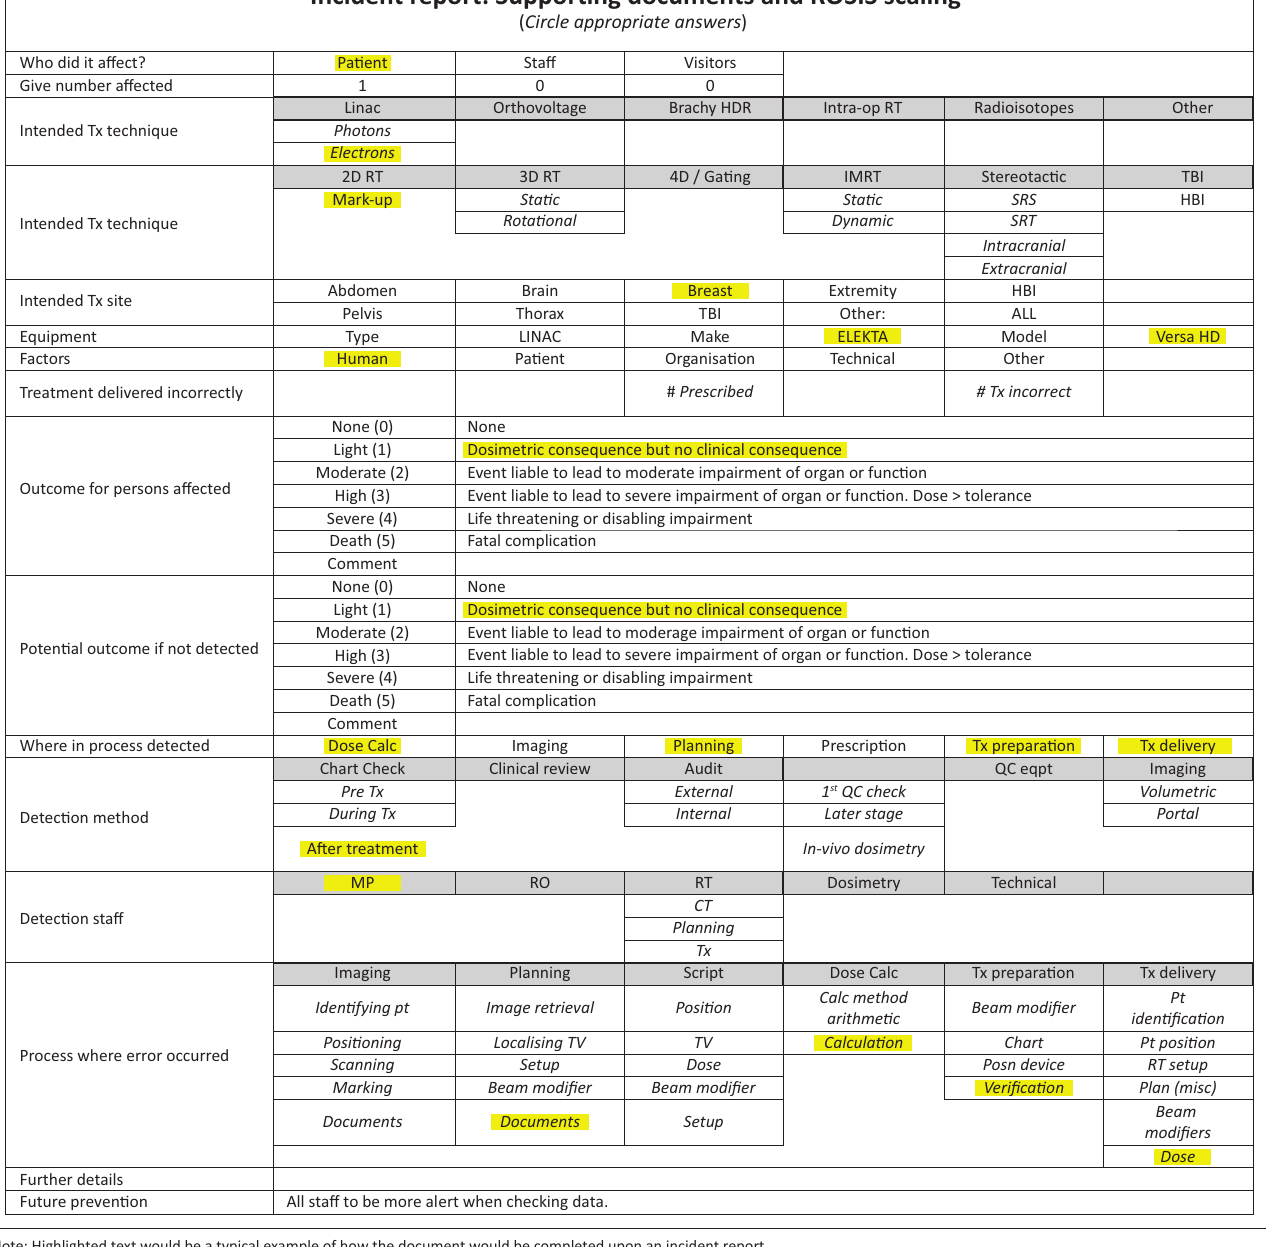
FIGURE 2: Independent clinical oncology network’s incident report supporting